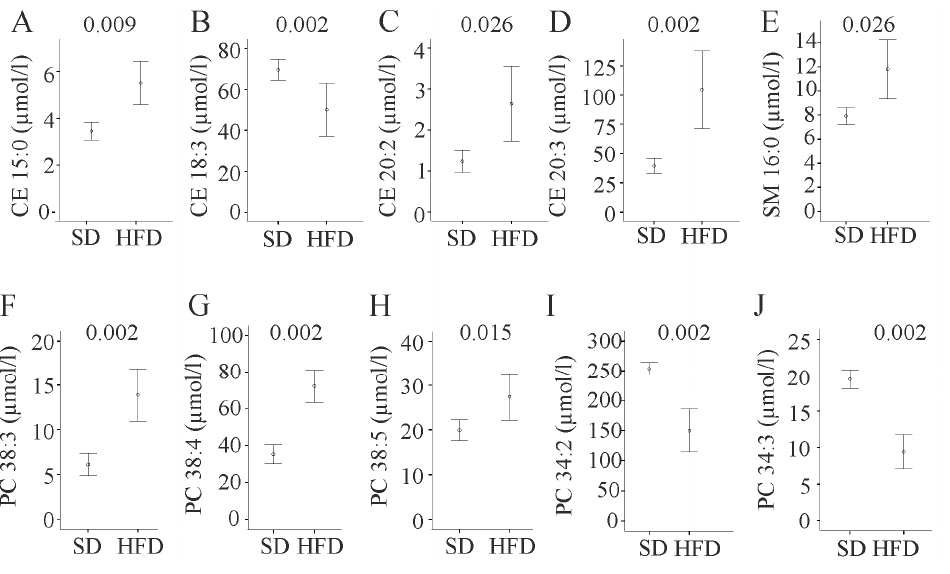
Figure 2. Cholesteryl ester (CE), sphingomyelin (SM), and phosphatidylcholine (PC) species in serum of mice fed a standard chow (SD) or high fat diet (HFD) for 14